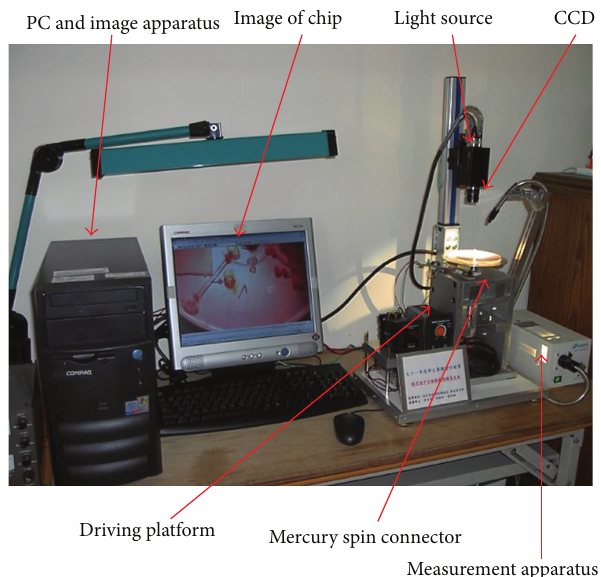
Figure 6: Equipment of centrifugal microfluidic system.